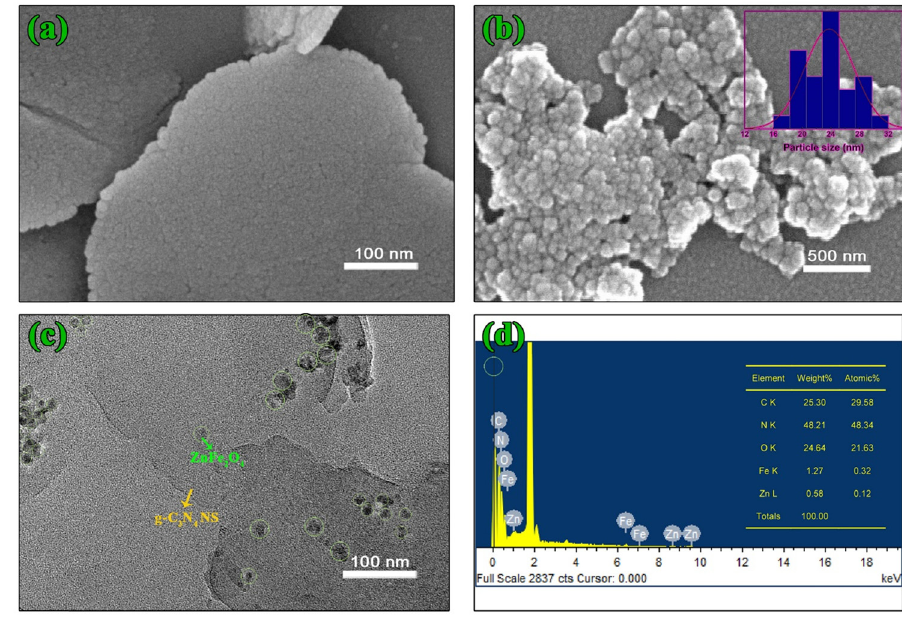
Figure 2: SEM images of ( a ) CNNS, ( b ) ZFNP, ( c ) TEM image of ZFNP – CNNS, and ( d ) EDX spectra of ZFNP – CNNS.